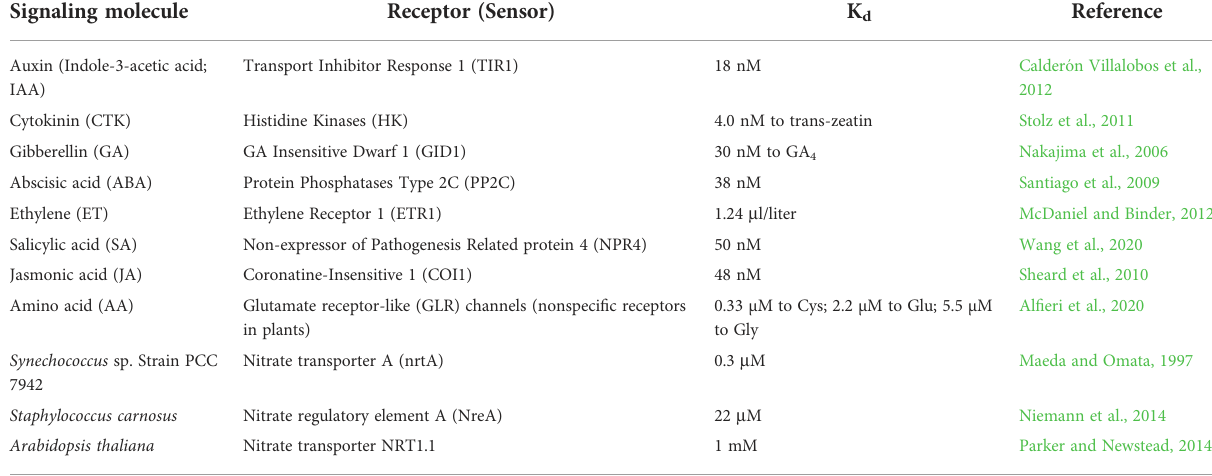
TABLE 1 Dissociation constant (K d ) values of phytohormone, amino-acid receptors (sensors) and nitrate transporters. Signaling